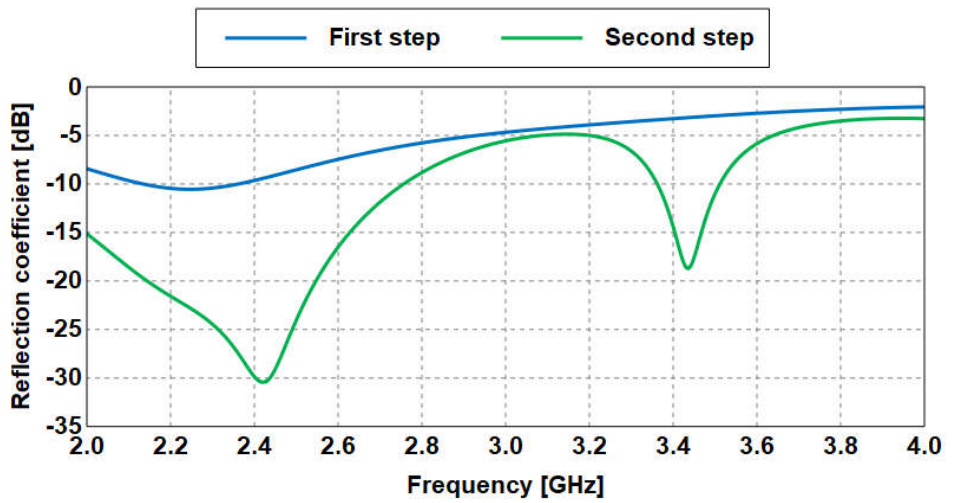
Figure 15. Reflection coefficients of Steps 1 and 2 of the proposed method in designing the dual band slot antenna.